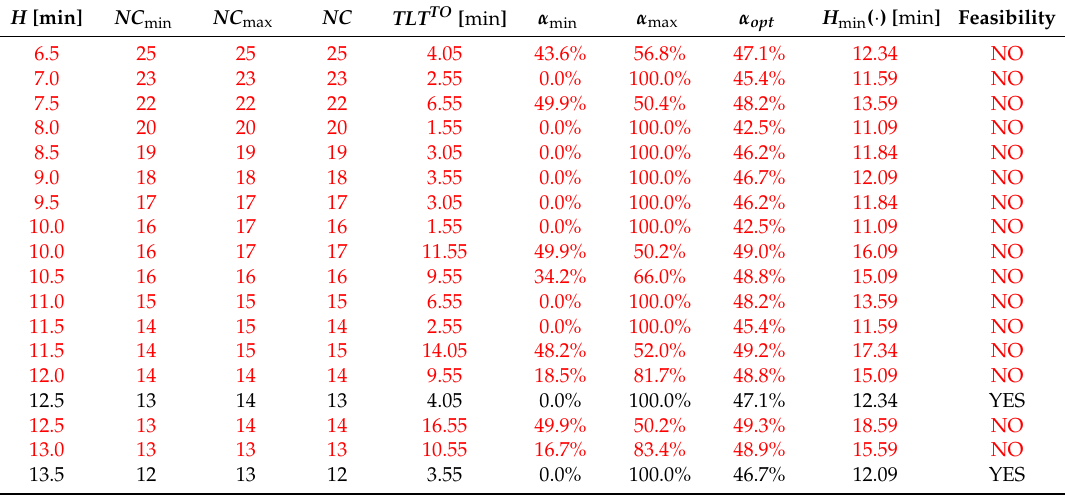
Table 3. Operational schemes in the case of 95th percentile (black = feasible configurations; red = unfeasible